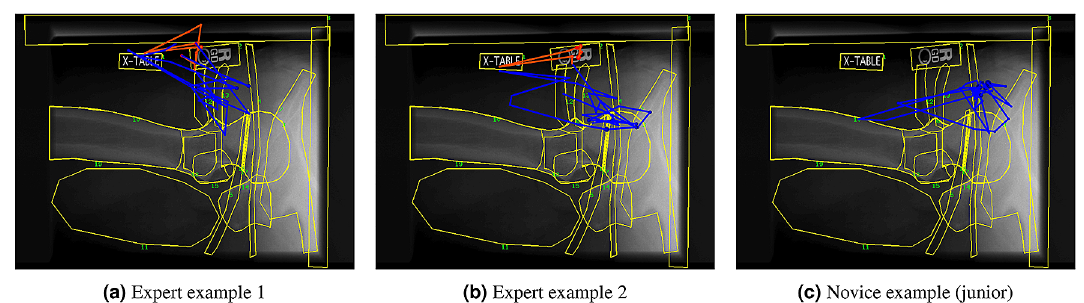
Figure 2. Example eye movement sequences for Task 4. ROIs are marked with yellow lines. The connected blue lines and circles on each image show an entire eye movement sequence by one participant. Each circle is a fixation in the sequence, and its size represents the fixation duration. The red subsequences highlight the contrast pattern by experts which checks the R marks and the label. The sequences are plotted with Matplotlib 43 .